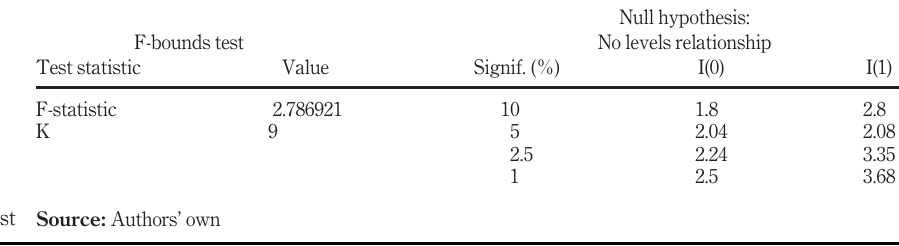
Table 5. Results of bound test